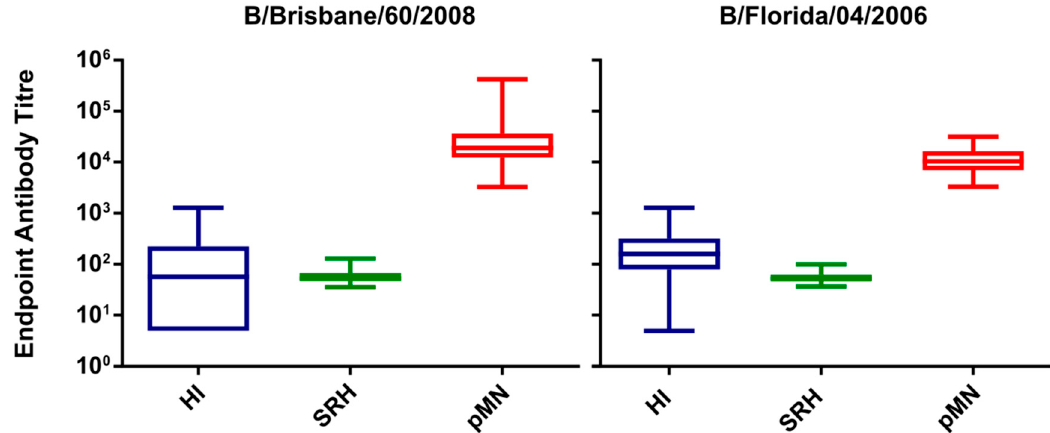
Figure 5. Haemagglutination Inhibition (HI), Single Radial Haemolysis (SRH) endpoint titres and pMN IC 50 values for high responders (V2) against B/Brisbane/60/2008 and B/Florida/04/2006. Titres displayed show similar profiles for each strain tested, with a broader range of pMN IC 50 values for B/Brisbane/60/2008.